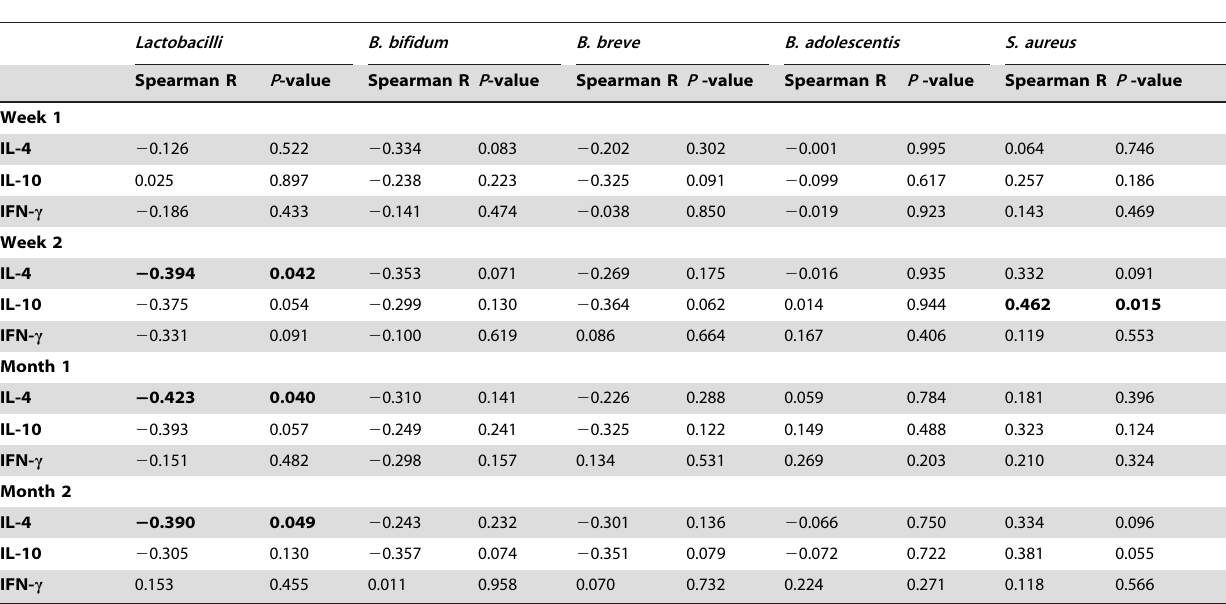
Table 2. Relative amounts of infant gut bacterial species in relation to cytokine secreting cells at two years of age.